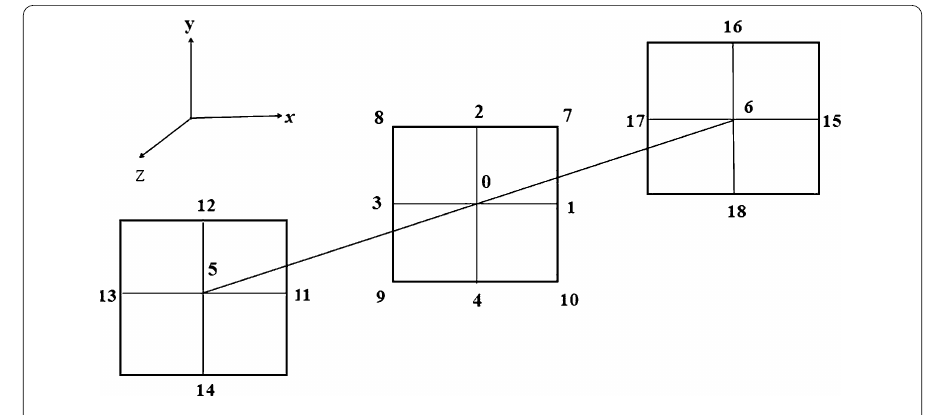
Figure 1 The 19-point stencil of 3D